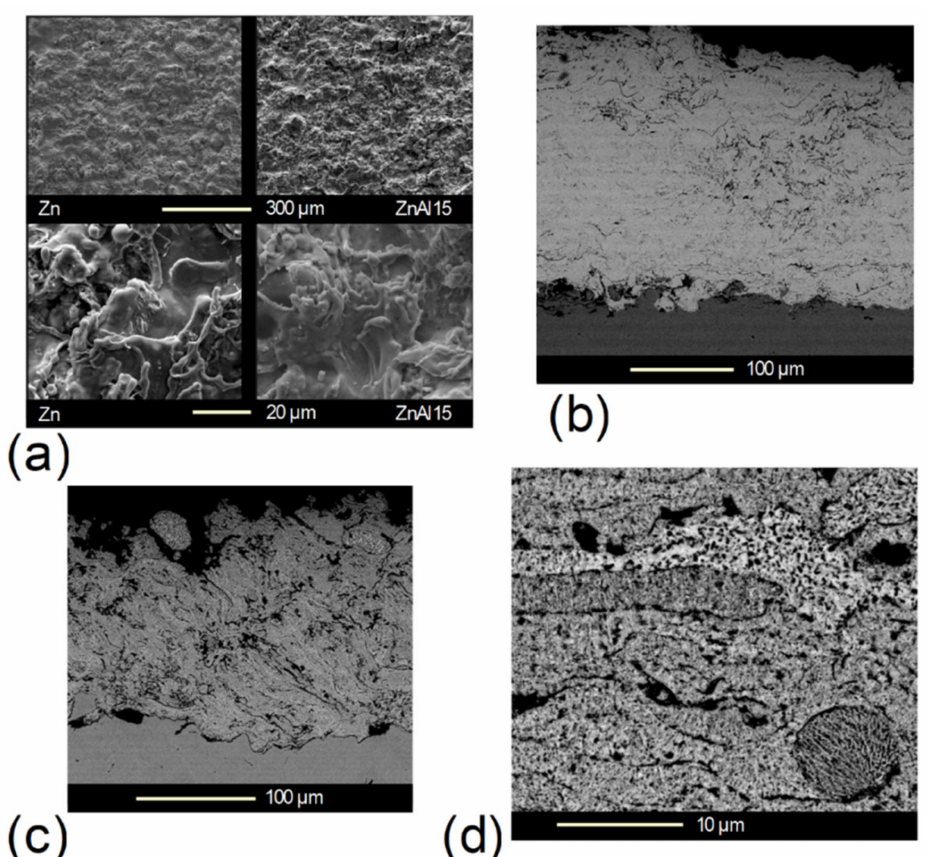
Figure 2. SEM images of the wire-arc-sprayed coatings. ( a ) Surface observations at two magnitudes, ( b ) cross-section observation of the Zn coating, ( c ) of the Zn-15wt.%Al coating, and ( d ) detailed view of the Zn-15wt.%Al coating